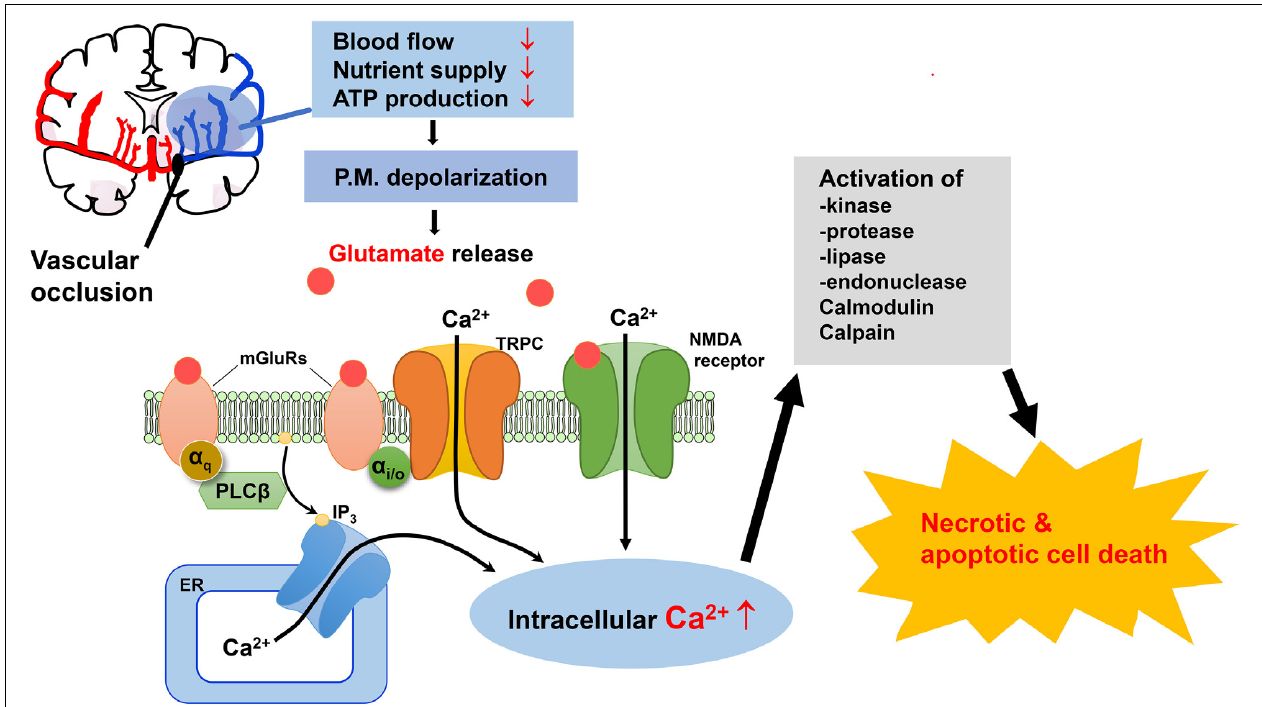
FIGURE 1 | Possible mechanisms for the involvement of TRPC channels in excitotoxic neuronal death in ischemic stroke. Oxygen and glucose deprivation due to the blockade of blood flow to brain areas in ischemic stroke causes excess accumulation of extracellular glutamate. The subsequent activation of NMDA receptors and mGluRs causes elevation of intracellular Ca 2 + levels through Ca 2 + influx from extracellular space and Ca 2 + release from the ER, respectively. TRPC channels are activated downstream from mGluRs, causing more sustained Ca 2 + elevation by mediating additional Ca 2 + influx. TRPC4 and TRPC5 channels are also activated downstream from mGluR subtypes that couple to PTX-sensitive G i / o proteins, further expanding the repertoire of receptors that convey glutamate stimulation to Ca 2 + signaling. Moreover, membrane depolarization resulting from activation of NMDA receptors and TRPC channels leads to excitation which also triggers additional Ca 2 + influx through voltage-gated Ca 2 + channels. The rise in intracellular Ca 2 + due to these mechanisms causes activity changes of a plethora of enzymes, ion channels and transcription factors, as well as mitochondria, which when dysregulated induce cell death via either necrosis or apoptosis. ER, endoplasmic reticulum; IP 3 , inositol 1,4,5-trisphosphate; mGluRs, metabotropic glutamate receptors; NMDA, N -methyl- D -aspartate; P.M., plasma membrane; PTX, pertussis